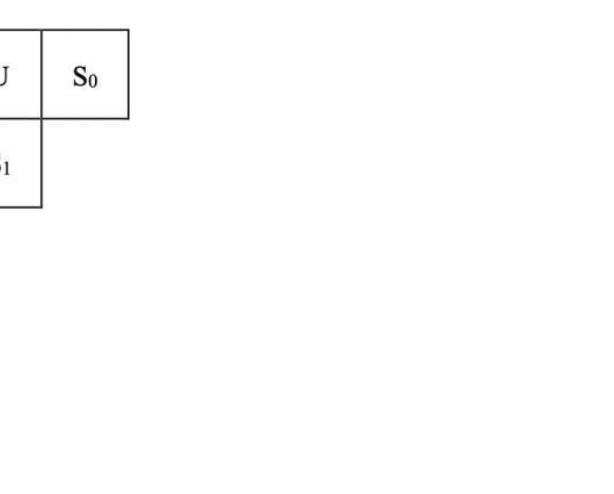
Figure 3. Logical relationship between factors. S 0 , S 1 , S 2 , S 3 , and S 4 represents the evaluation of urban and rural living environment governance effectiveness, LTM, ERS, IS, and EE, respectively. “N” signifies the row factor’s direct or indirect effect on the column factor, “U” denotes the column factor’s direct or indirect influence on the row factor, and “0” denotes the absence of an influence relationship. Based on calculations, the hierarchical structure matrix B is shown in Formula